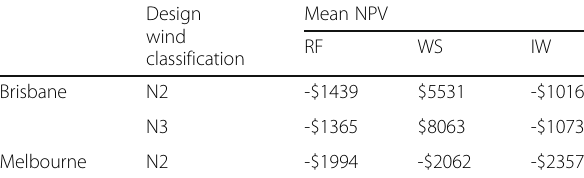
Table 11 Mean NPV when mislabeled windows are installed Design